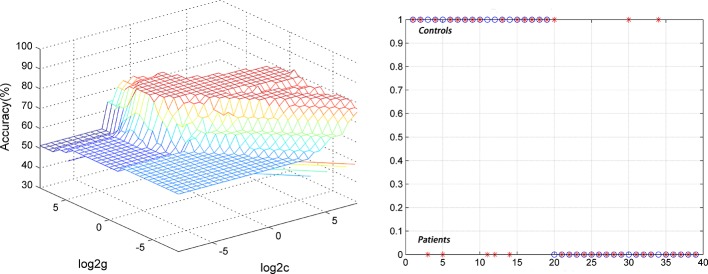
Using decreased NH values in the bilateral ventral MPFC to differentiate the patients (DPP group) from the controls. Visualization of classifications through support vector machine (SVM) using the NH values in the significantly different regions. Left: SVM parameters selection result of 3D view; Right: Classiﬁed map of the NH values in the bilateral ventral MPFC.